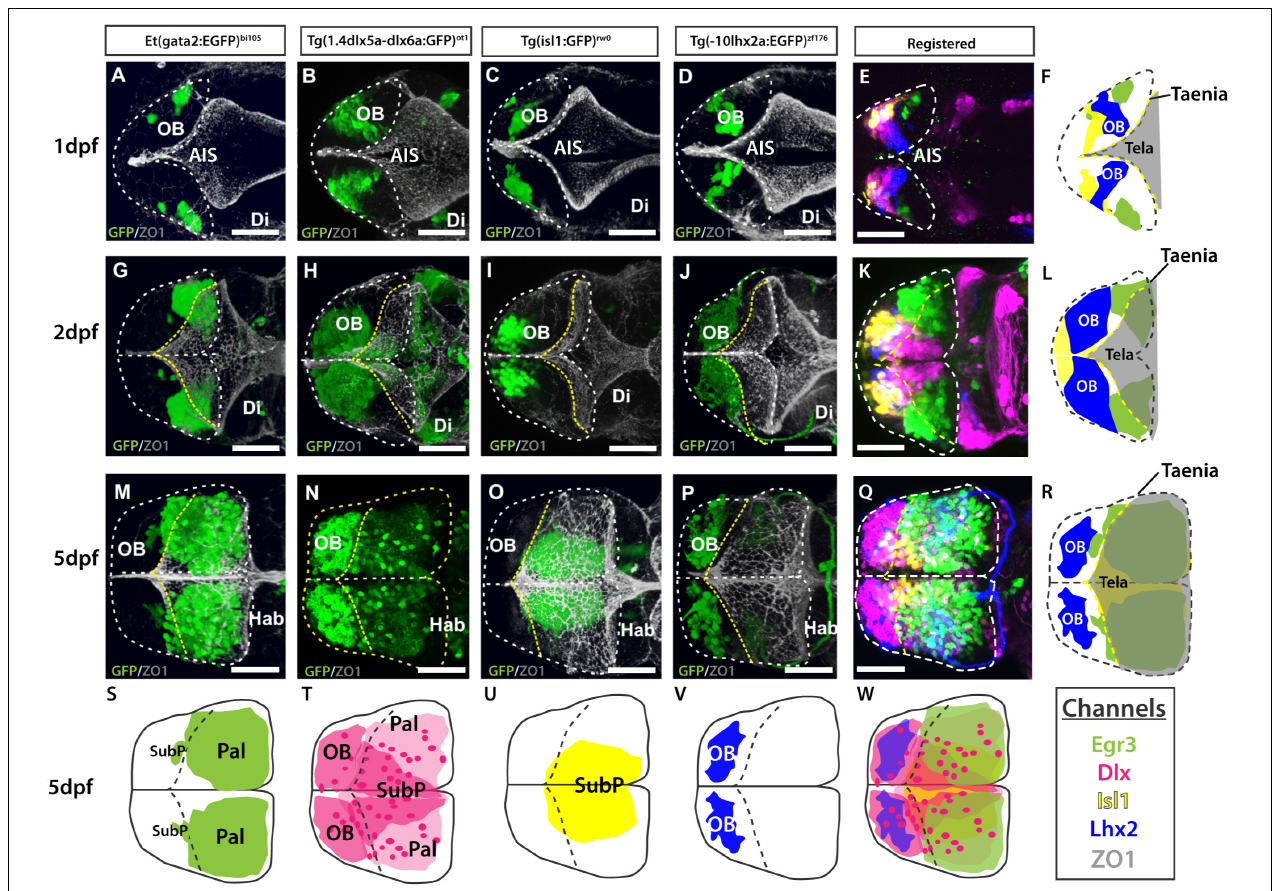
FIGURE 10 | Atlas of transgene expression in the developing telencephalon. Dorsal views. Et (gata2:EGFP) bi105 in comparison with Tg( 1.4dlx5a-dlx6a :GFP) ot1 , Tg( isl1 :GFP) rw0 , Tg(- 10lhx2a:EGFP ) zf176 . ZO1: ventricular zone and tela choroidea . Dorsal views of 1dpf, 2dpf and 5dpf fish stained against GFP and ZO1. Images are projections of confocal stacks. Rostral to the left. White dashed line in panels (A–R) marks the outline of the telencephalon. Yellow dashed marks in A-R the rostral attachments of the tela choroidea or taeniae. (F,L,R) Schematics showing the location of GFP+ cells in each transgenic line relative to the ZO1 positive tela choroidea (semi-opaque gray) over development, showing the expansion of the tela and rearrangement of telencephalic domains. The taenia is the point of attachment of the tela choroidea . (S–V) Schematics showing the location of the GFP+ cells in each transgenic dataset by 5dpf. Black dashed line marks the rostral attachments of the tela choroidea or taeniae . (E,K,Q) Transgenic datasets registered to a single reference brain for each developmental stage. (W) Schematic of all registered GFP+ expression. Channels key below final column shows the color of each transgenic within the composite images and schematics. Scale bars: 50 µ